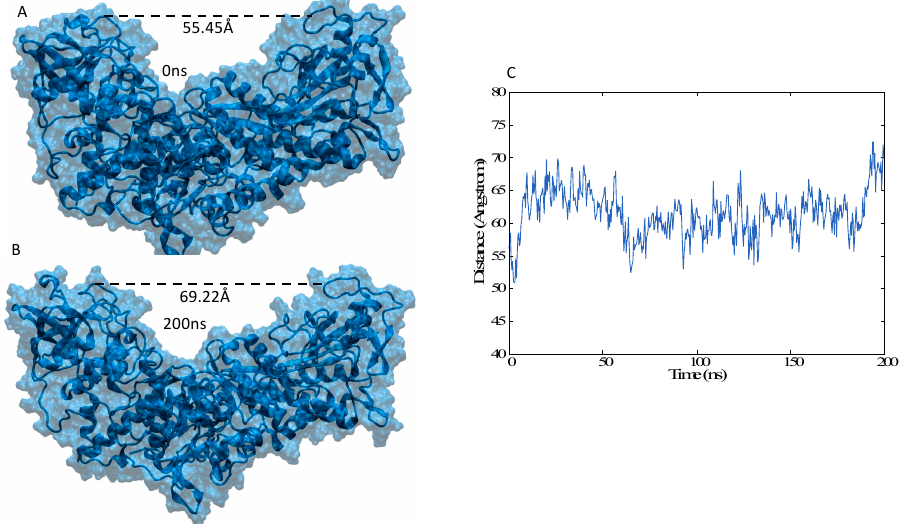
Figure 5. Representative snapshots of unbound IRP ( A , B ) and time series of the evolution of the distance between the extremities of the pincer-like domains ( C ).